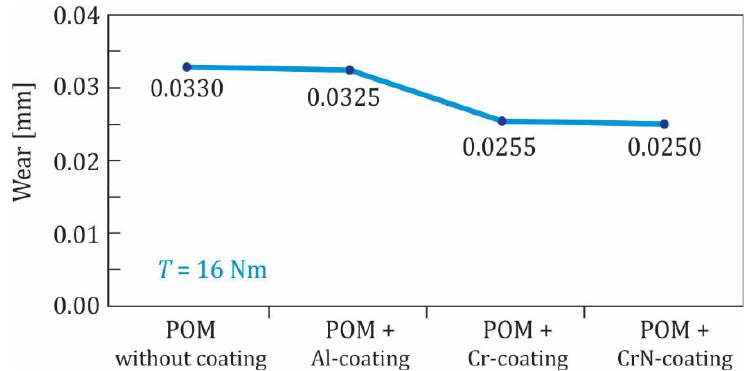
Figure 10. Wear of POM-gears without coating at different torques.